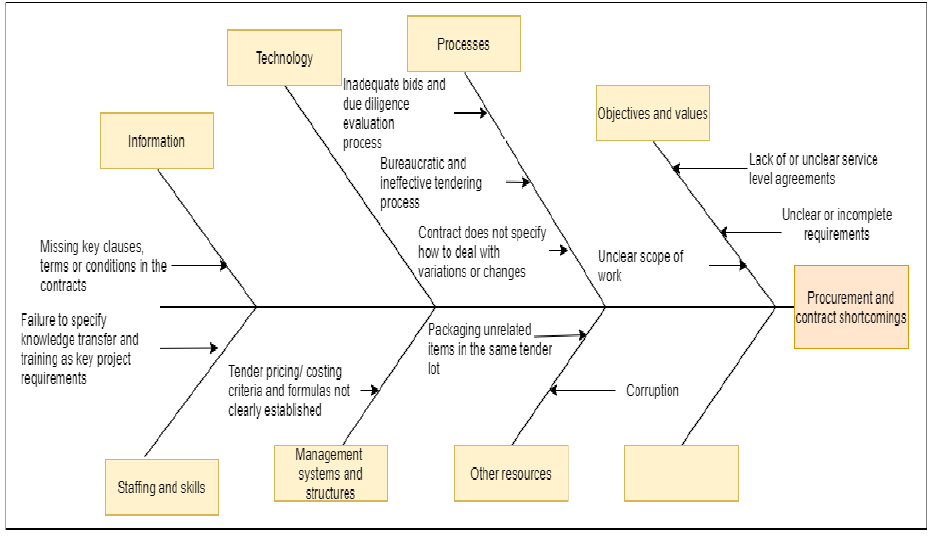
Figure 9: Procurement and contract